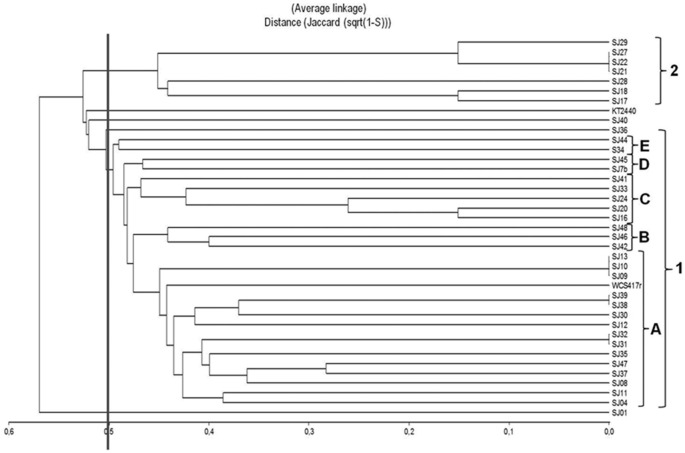
Dendrogram based on BOX-PCR profiles, generated from native, and reference Pseudomonas strains using the UPGMA algorithm and Jaccard coefficient.